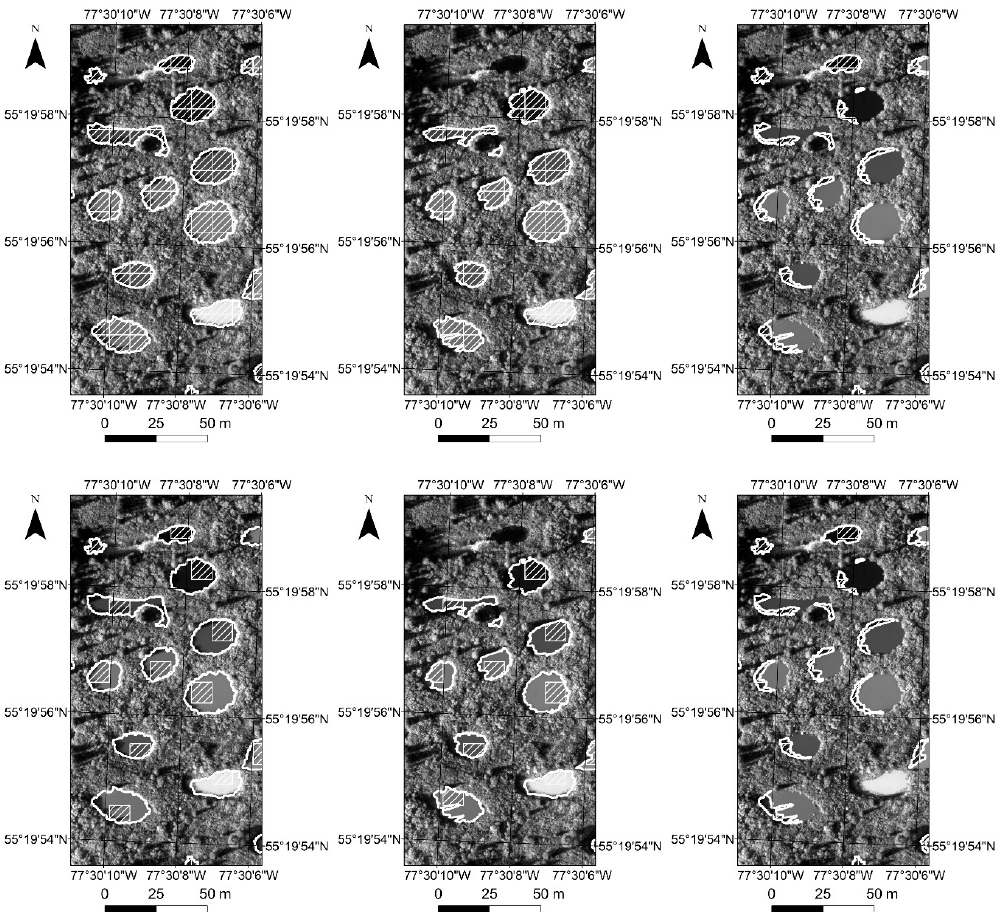
Figure 8. Methods used for the extraction of surface reflectance from the lake and pond surfaces from the Sentinel-2 imagery. Upper row: averaging the whole area (M1 S2), lower row: considering the value of the largest pixel (M2 S2). Left column: full-water body (FWB), Center column: sunlit water body (SLW), right column: shaded water body (SHD).